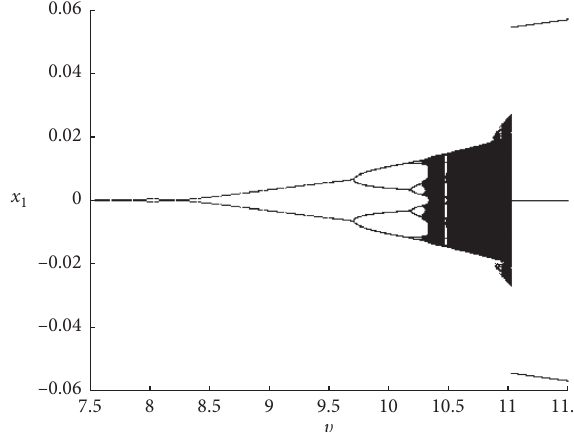
Figure 7: The bifurcation diagram for the nonlinear system of � 0 . 5, as υ is varied. Figure 6 with l 0